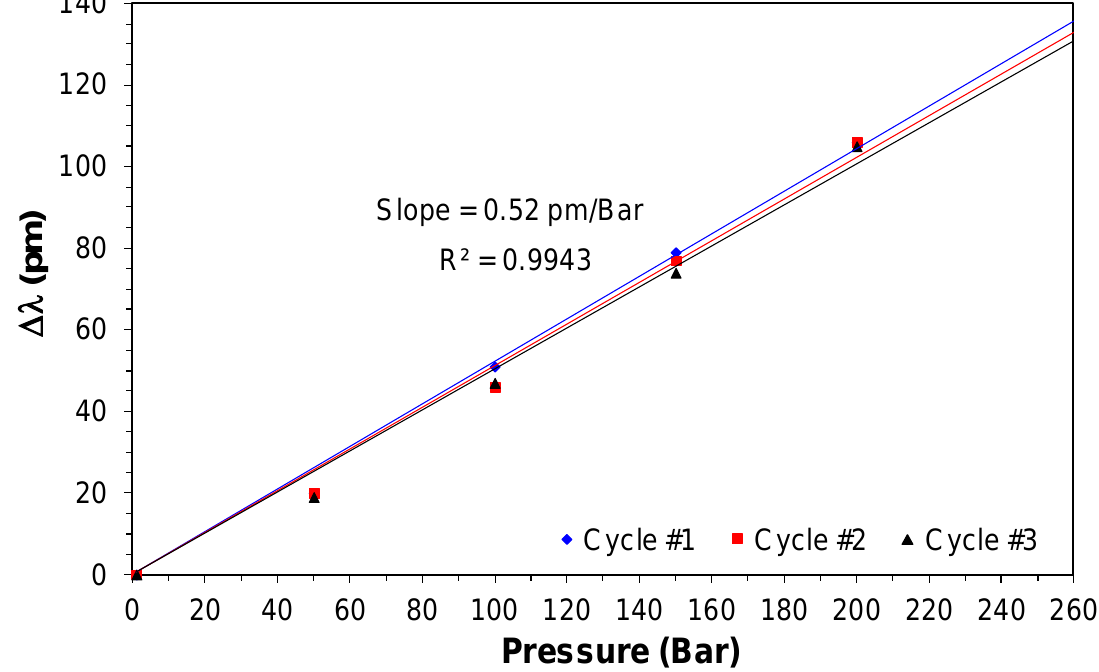
Figure 10. Wavelength shifting versus pressure sensor for sensor #1 used in the field test.